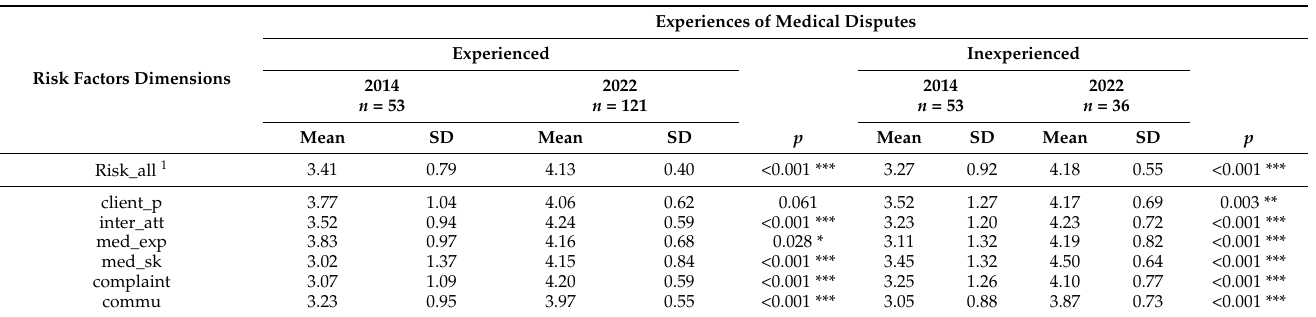
Table 10. Comparisons of the risk factor perceptions differences between 2014 and 2022 for medical disputes experience